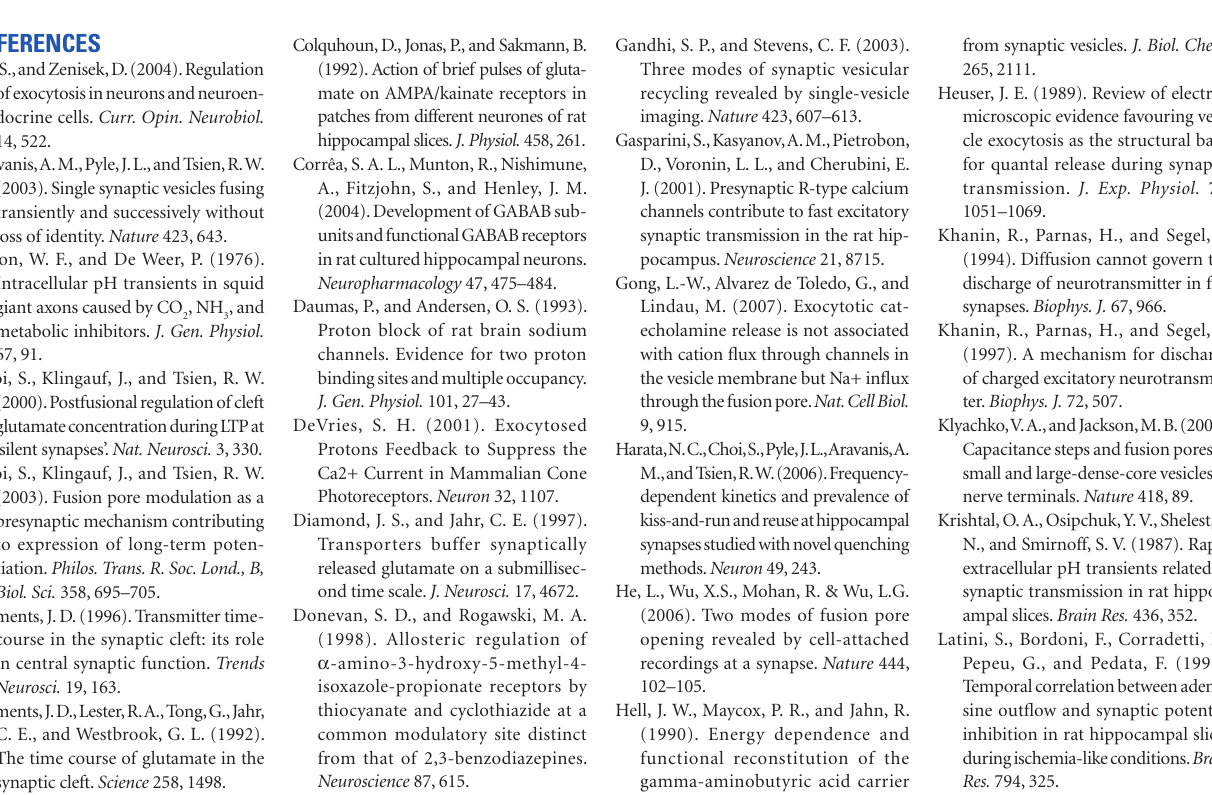
Figure 8 | FCCP does not immediately affect the amplitude of the gABA -mediated iPSC. (A) Diary plot of IPSC amplitude showing that the A initial mean IPSC after resumption of stimulation was unaffected by the application of FCCP (3 μM). Representative individual IPSCs from a single experiment show the final baseline response (i) and the first response evoked in FCCP (ii). The subsequent decline in IPSC amplitude upon stimulation is